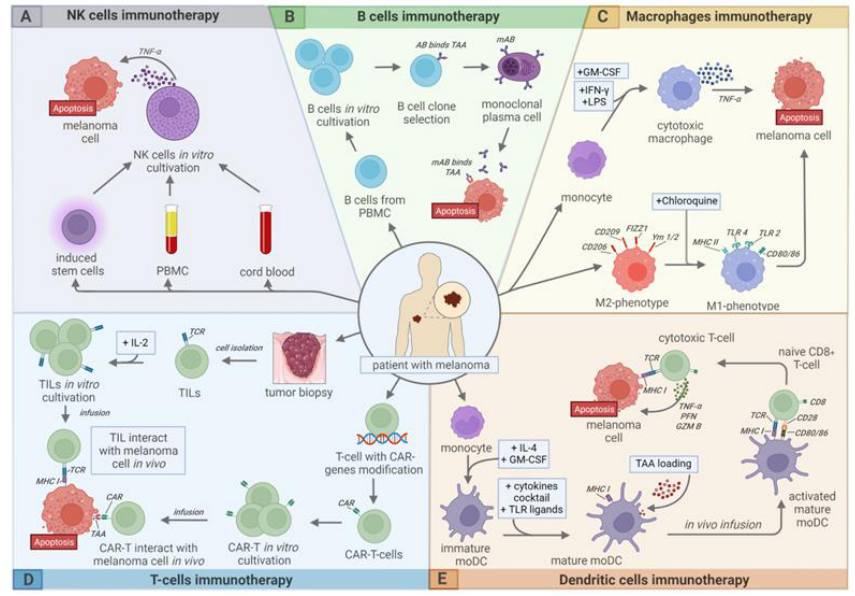
Figure 1. Modern approaches to cell-based immunotherapy of melanoma. ( A ) — NK cell therapy, ( B ) — B cell therapy, ( C ) — Macrophage therapy, ( D ) — T-cell therapy, ( E ) — Dendritic cell (DC) ther-